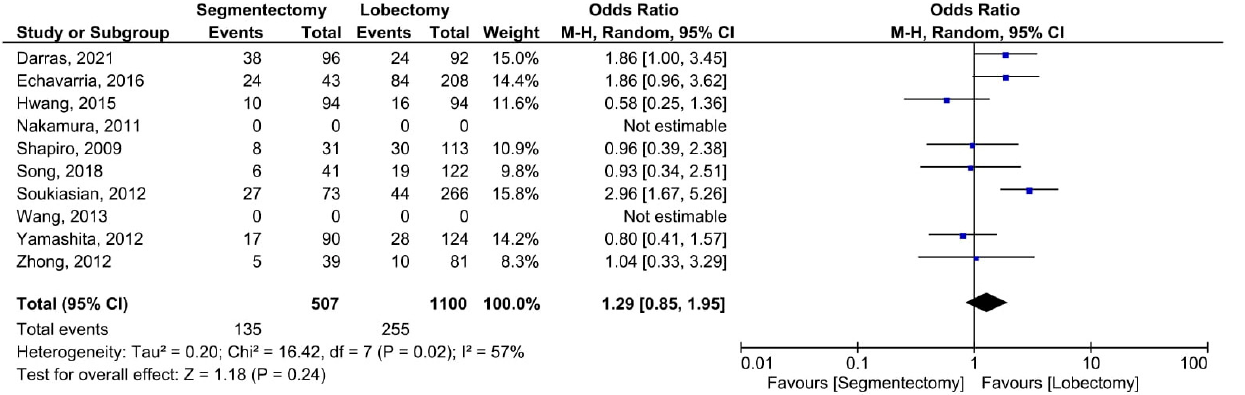
Figure 4. Forest plot for postoperative complications of the minimally invasive segmentectomy and lobectomy. CI = confidence interval; dF = degree of freedom; M–H = Mantel–Haenszel [8,12–20].